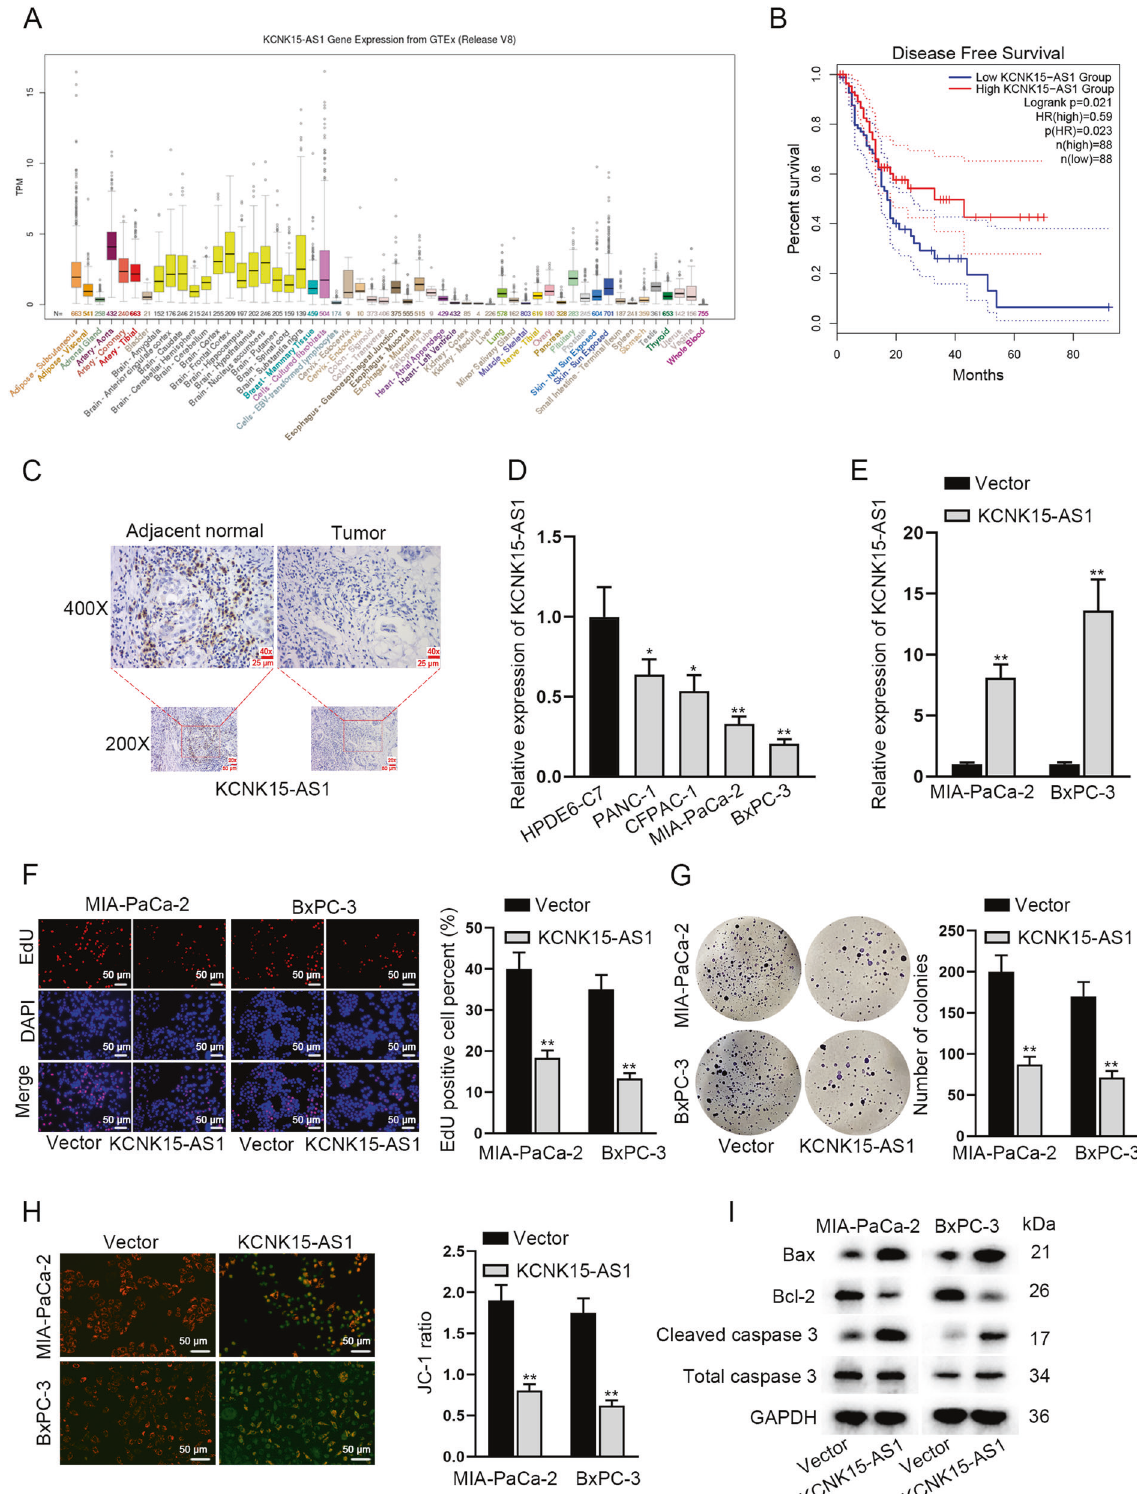
Fig. 1 KCNK15-AS1 inhibits PC cell growth. A KCNK15-AS1 expression in different normal tissues was revealed by UCSC. B GEPIA 2 data disclosed the correlation between disease free survival (DFS) and KCNK15-AS1 expression in PC patients. C KCNK15-AS1 expression was determined by ISH assay in PC samples and paired adjacent tissues (scale bar: 40×, 25 μ m; 20×, 50 μ m). D KCNK15-AS1 expression in human PC cells relative to normal HPDE6-C7 cells was determined by RT-qPCR. E RT-qPCR analysis validated KCNK15-AS1 overexpression ef fi ciencies in PC cells. F , G PC cell proliferation was examined by EdU (scale bar: 50 μ m) and colony formation assays. H PC cell apoptosis was assessed by JC-1 assays. I Impact of KCNK15-AS1 on apoptosis-related proteins including Bax, Bcl-2 and cleaved caspase-3 was analyzed by western blot in PC cells. * P < 0.05, ** P <